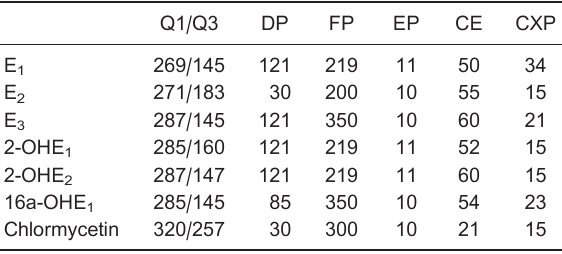
Table 2. Mass spectrometry parameters of HPLC-ESI-MS/MS measurements of estrogen metabolites and chlormycetin.